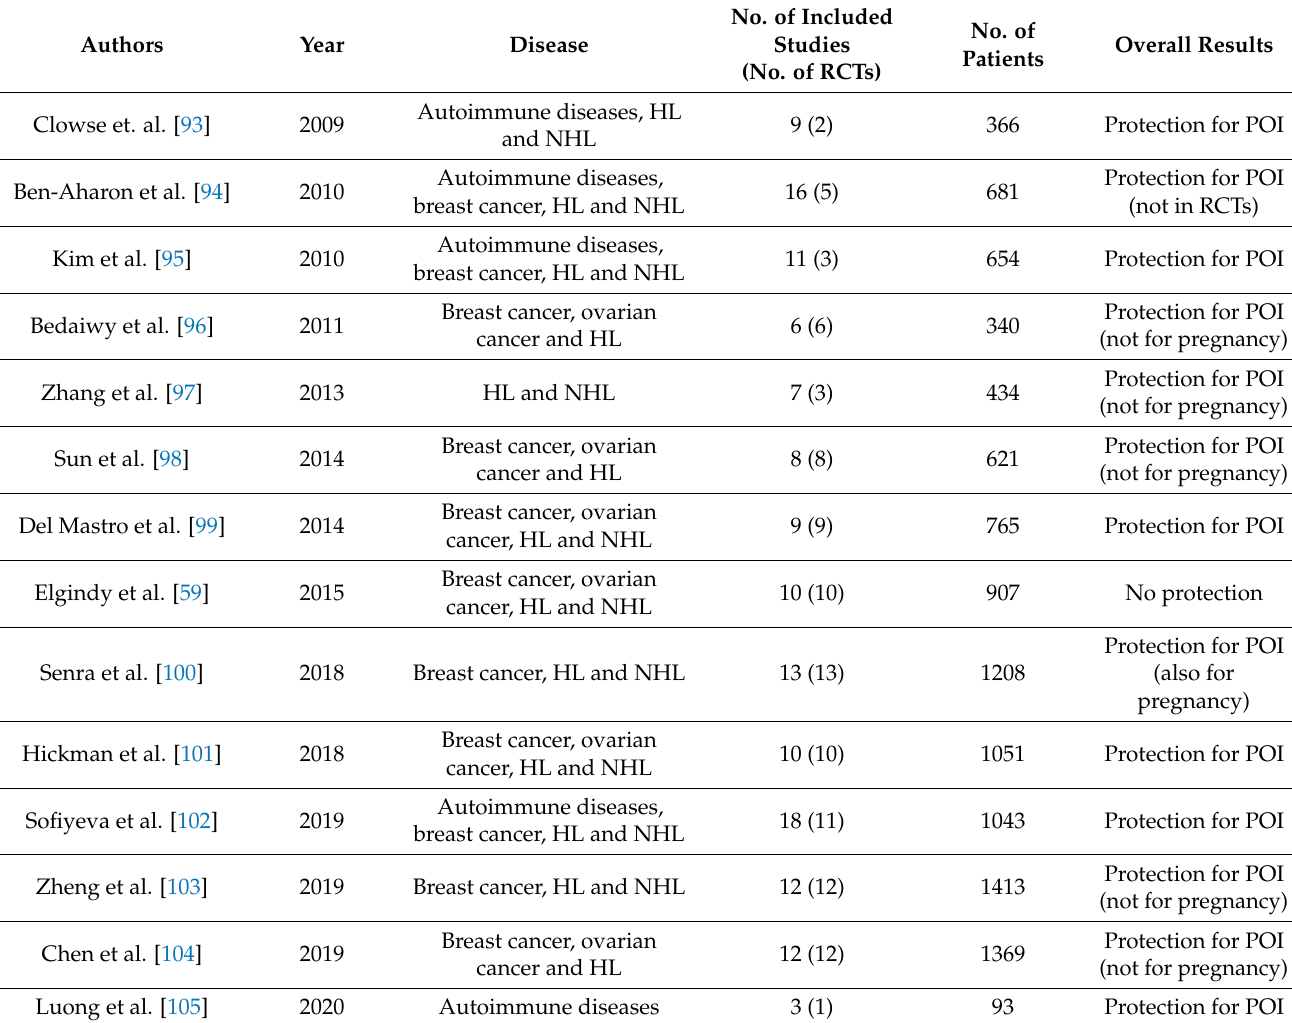
Table 4. Available meta-analyses assessing temporary ovarian suppression with GnRHa during chemotherapy in patients with malignancies other than breast cancer or not restricted to only breast cancer